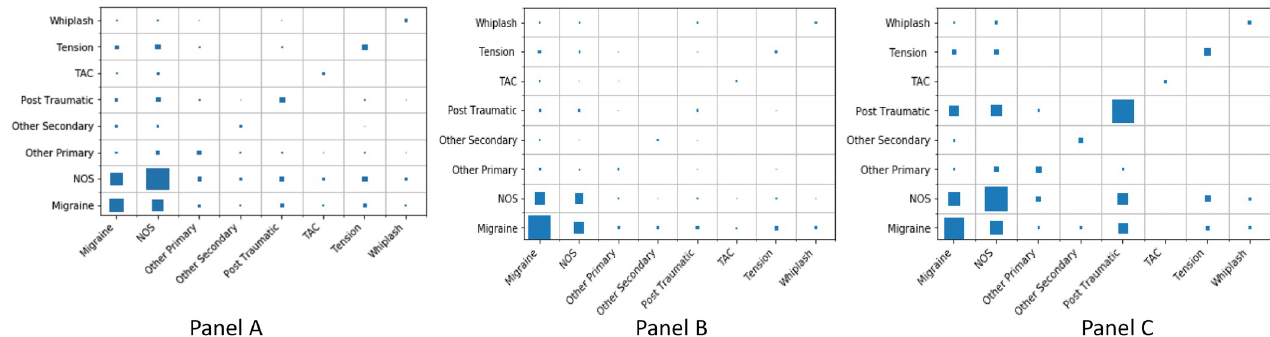
Fig 2. Panel-A: Headache NOS coding. Panel-B: Migraine headache coding. Panel-C: PTH headache coding in FY2016/2017. Abbreviations: Not-otherwise- specified (NOS); Trigeminal autonomic cephalalgia (TAC); Post-traumatic headache (PTH).